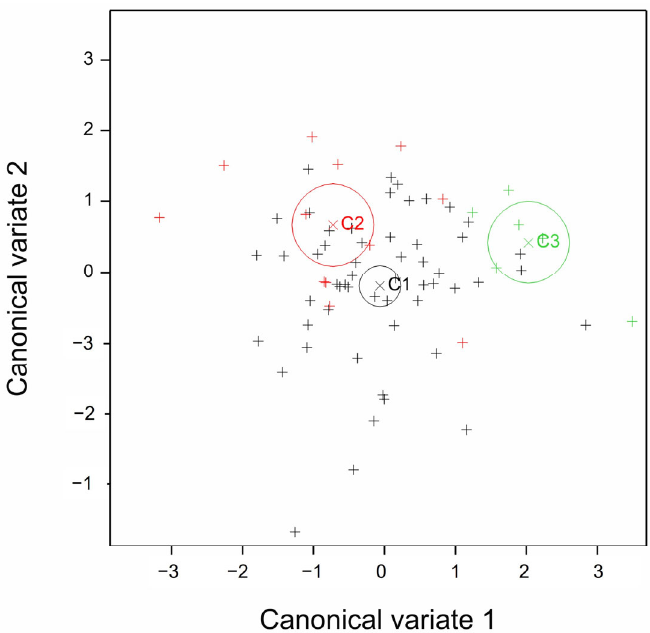
Figure 7. The canonical variate analysis of three groups (C1, C2 and C3) in S 2 generation derived from an allohexaploid Brassica hybrid H16 ‐ 1.